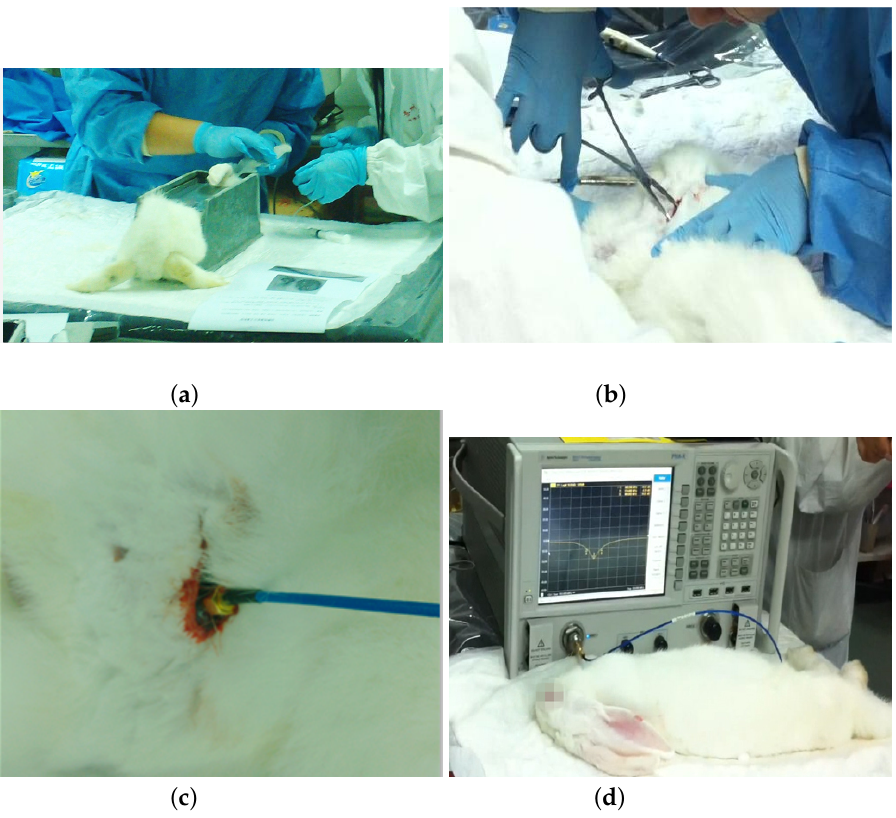
Figure 13. Surgical implantation of the antenna into the rabbit. ( a ) Anesthetizing the rabbit. ( b ) Inci- sion made through the skin. ( c ) Placement of the implantable antenna. ( d ) Measurement setup.